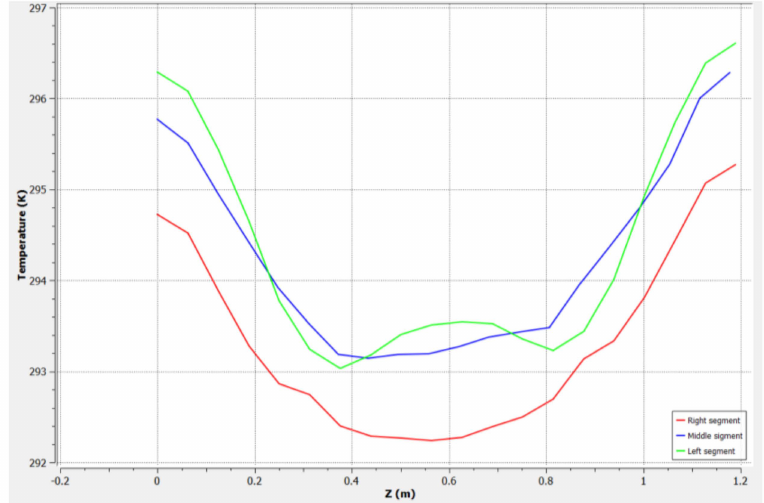
Figure 13. Temperature distribution of the cooling panel for Design